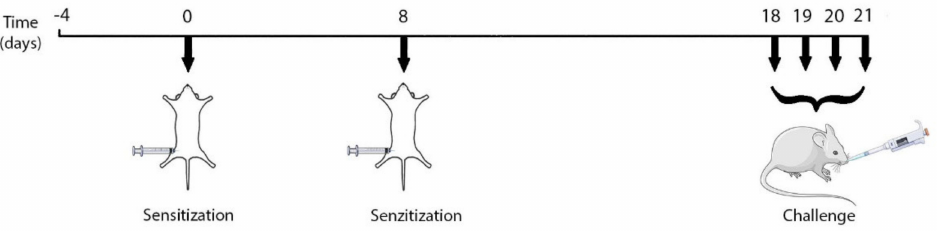
Figure 7. Timeline of mouse model induction. Graphical elements retrieved from https://smart. servier.com/ (accessed on 21 February 2021).